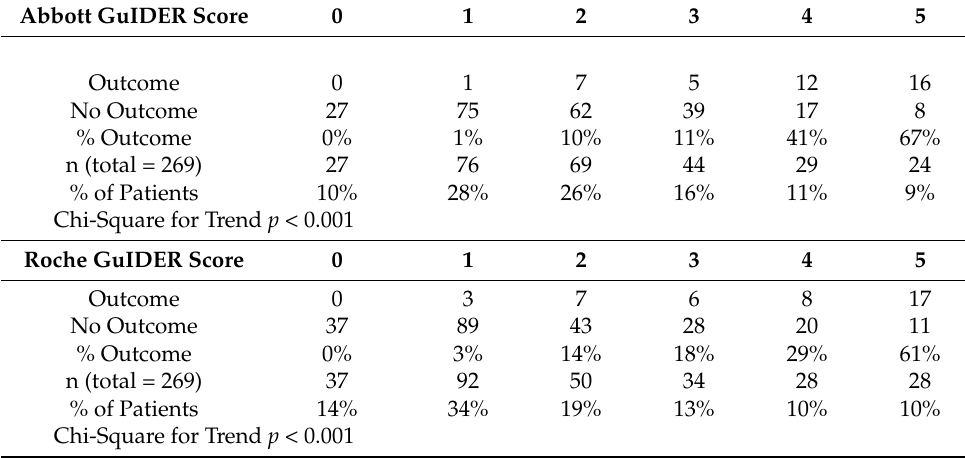
Table 3. Percentage of primary outcome per the GuIDER scores using both Abbott hs-cTnI and Roche hs-cTnT for the combined cohorts.